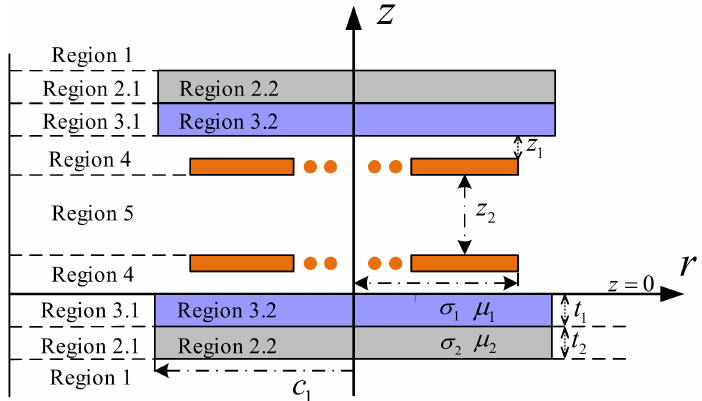
Figure 16. Distribution of magnetic field lines before and after